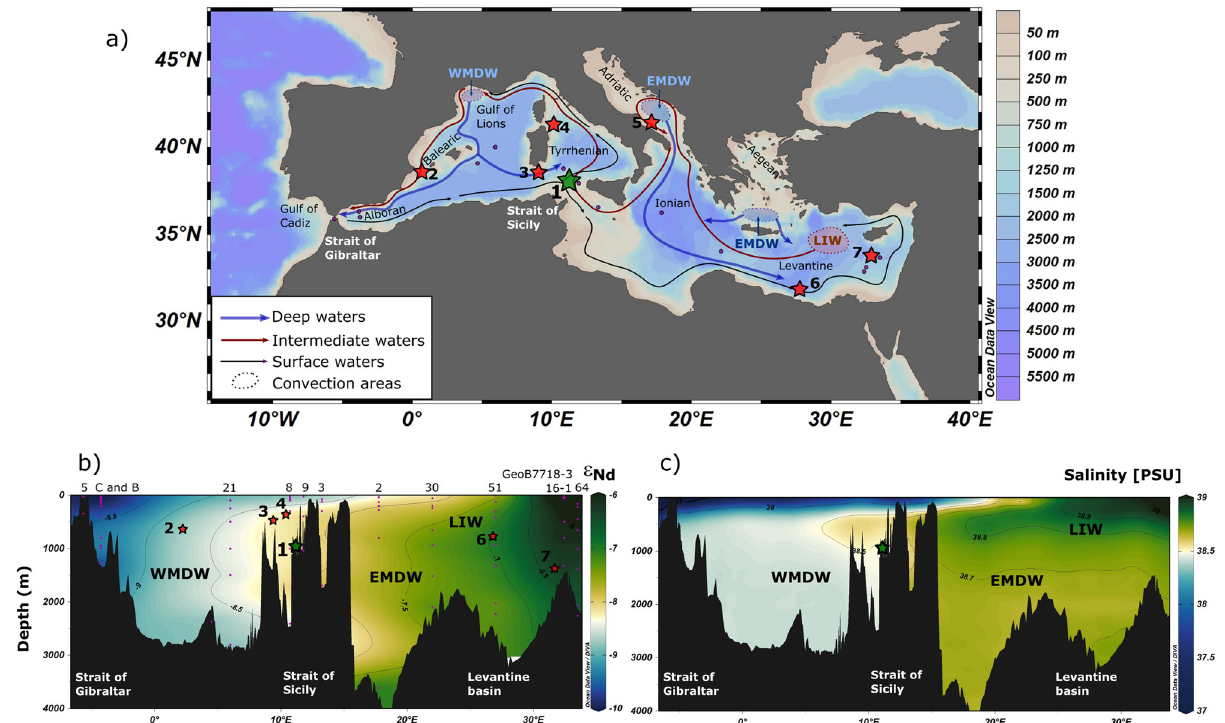
Fig. 1 Neodymium and salinity modern values of the Mediterranean Sea. a Map of the study area in the Mediterranean Sea. Modern surface and deep hydrology of western and eastern Mediterranea Sea represented in the map is based on ref. 2 – 4 . Basic map of the Mediterranean Sea obtained from Ocean Data View. The green star represents the studied core NDT-6-2016 (1) and red stars represent the other cores discussed in this manuscript located in both the western and eastern Mediterranean Sea: 2) SU92-33 and 3) RECORD23 41 , 4) MD01-2472 and 5) MD90-917 39 , 6) MS27PT 42 and 7) BC07 51 . Violet circles stand for the stations of the obtained present-day seawater ε Nd values. Blue arrows indicate deep waters (Western -WMDW- and Eastern -EMDW- Mediterranean Deep Waters), red arrows represent Levantine Intermediate Water (LIW) and black ones the surface Modi fi ed Atlantic Water (MAW). b Map of the seawater neodymium distribution in the Mediterranean Sea based on previous acquired data from stations (violet circles): B, C, 5, 51, 64; 47 8, 9, 3, 2; 49 GeoB7718-3, GeoB7716-1; 44 21 60 . c Map of the salinity distribution in the Mediterranean Sea based on Medatlas II acquired